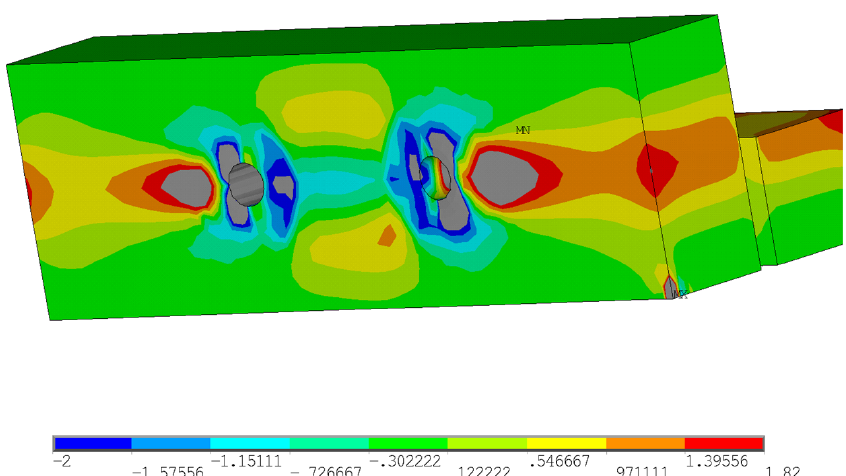
Figure 17. Normal stress in the Y direction (tension and compression perpendicular to the grain).